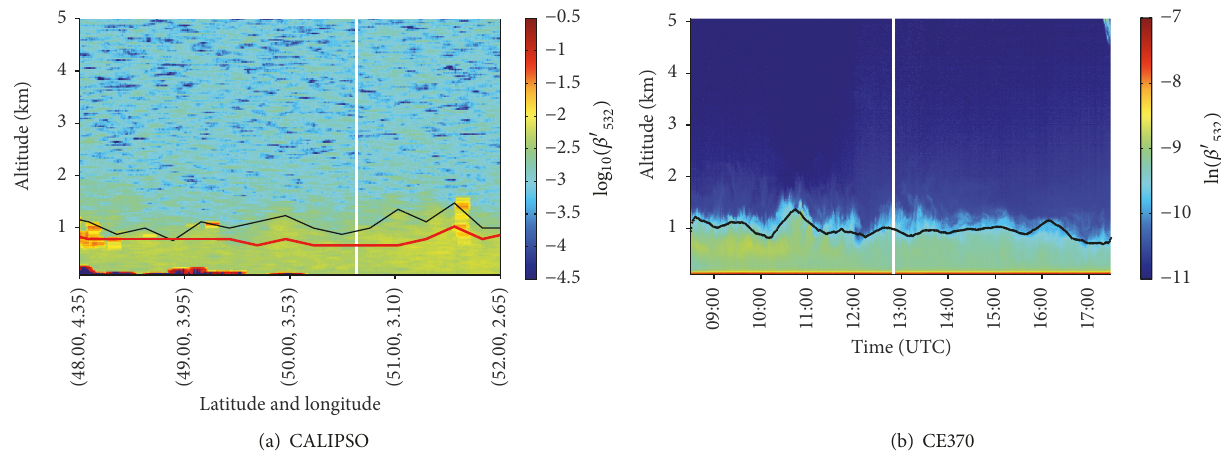
Figure 3: Vertical profiles of total attenuated backscatter at 532 nm; (a) was acquired from CALIOP, while (b) was acquired from ground- based Lidar (CE370), which were all measured on December 31, 2015. The PBLH results derived by the maximum variance method developed by Jordan et al. (red bold line) and the improved maximum variance method (black line) are, respectively, shown in (a) along with latitude and longitude, while in (b), the PBLH results (black points) were derived by wavelet method from CE370 observations during daytime, which are relative to sea level. The vertical white solid lines in (a) and (b) indicate the points of the nearest spatial and temporal coincidence between the CE370 Lidar site and the CALIOP footprint.